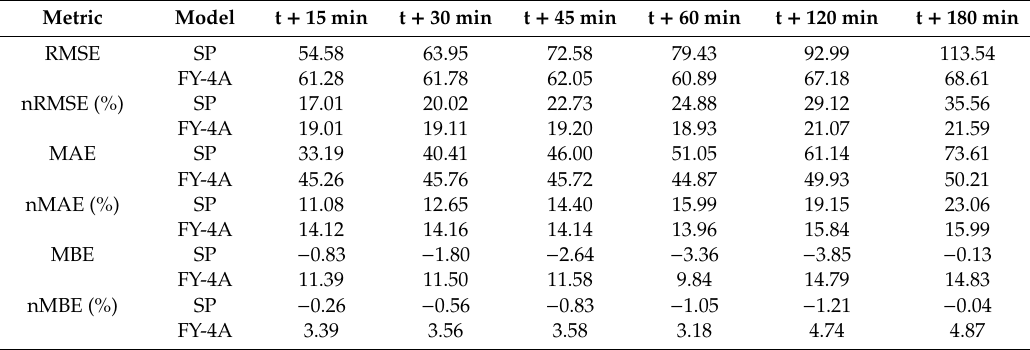
Table 5. Statistical indexes under all sky conditions with horizons from 15–180 min (in W / m 2 for the RMSE, MAE, and